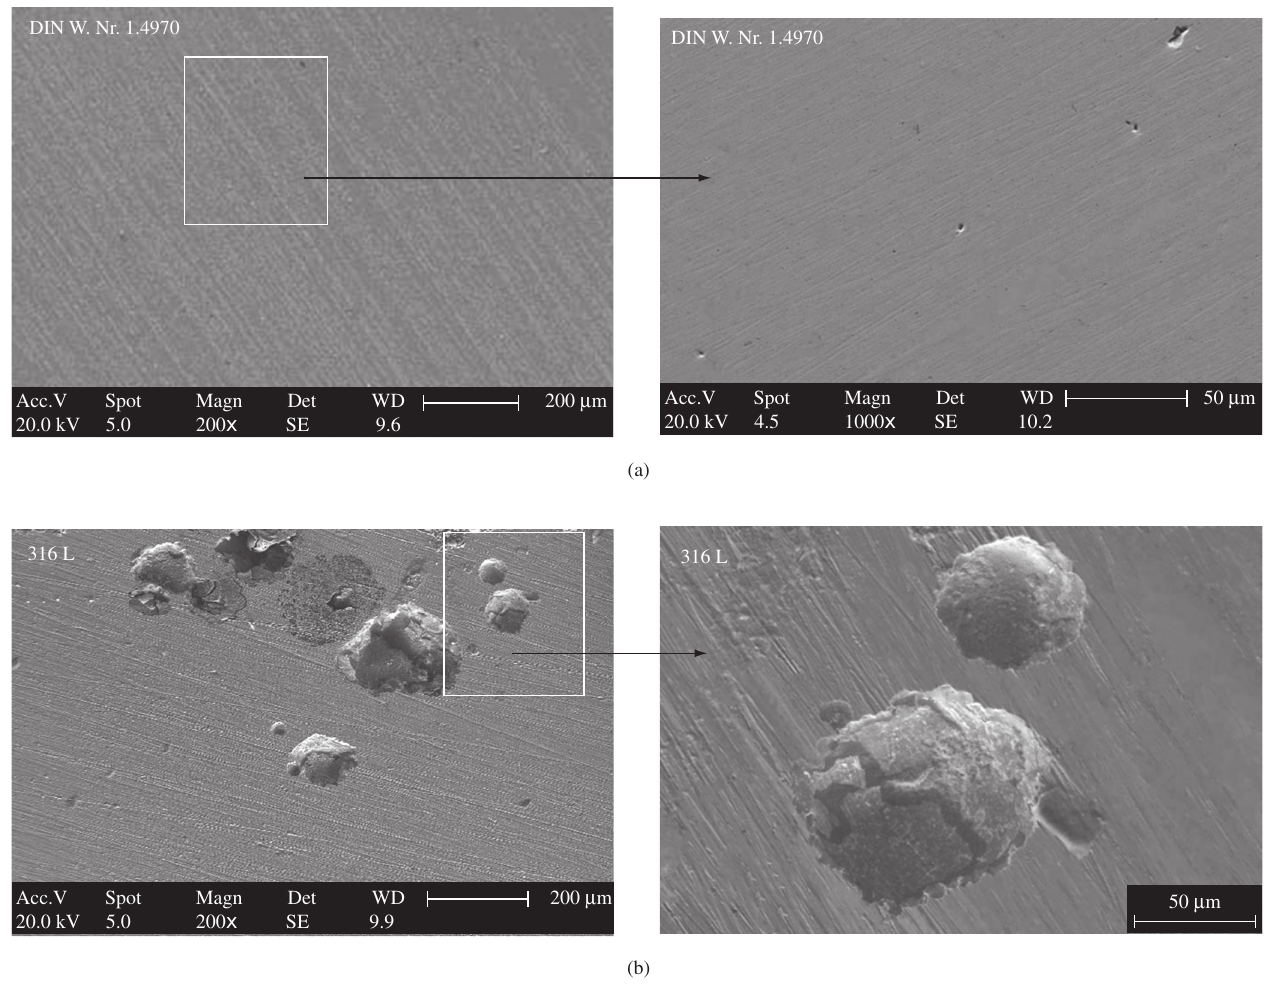
Figure 6. SEM micrographs of a) DIN W. Nr. 1.4970; and b) ASTM F-138 stainless steels after polarization in phosphate buffered